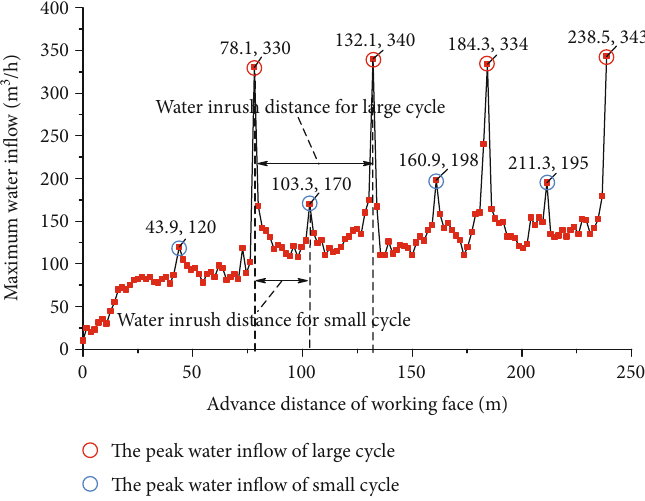
Figure 4: Relation between the advancing distance of the working face and the corresponding water in fl ow.